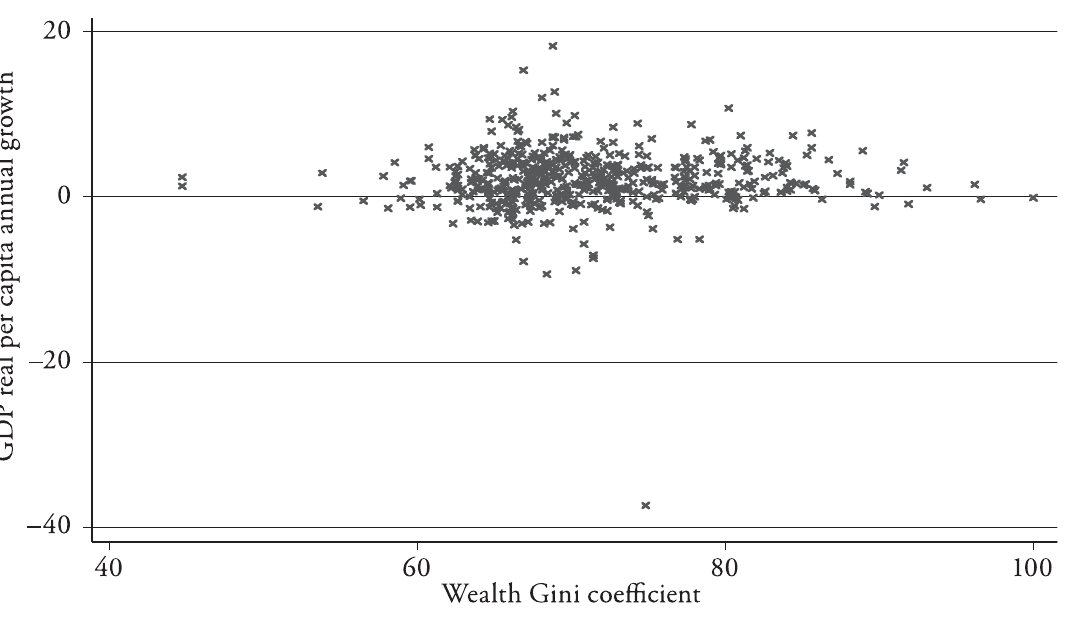
Figure 2.1: Scatterplot ofWealth Gini vs GDP Real Per Capita Annual Growth, 146 Countries,